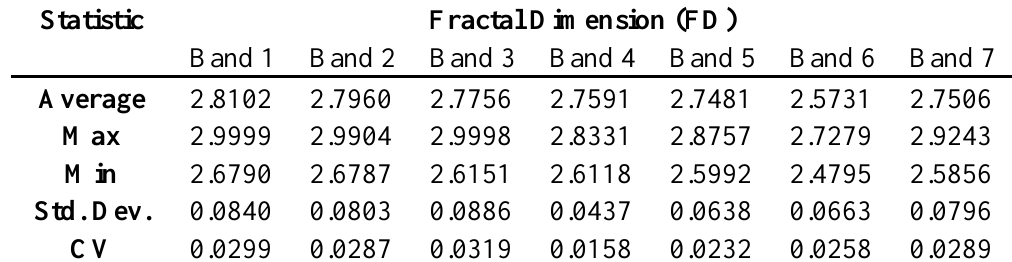
Table 6. Descriptive statistics of fractal dimensions for all bands: Oakmulgee National Forest.